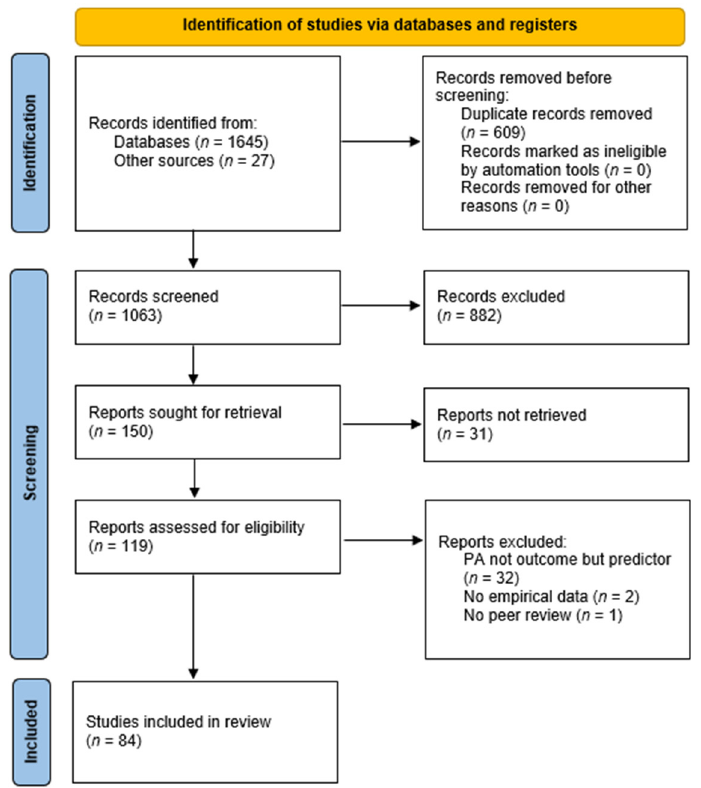
Figure 1. PRISMA flow chart of the study selection process.